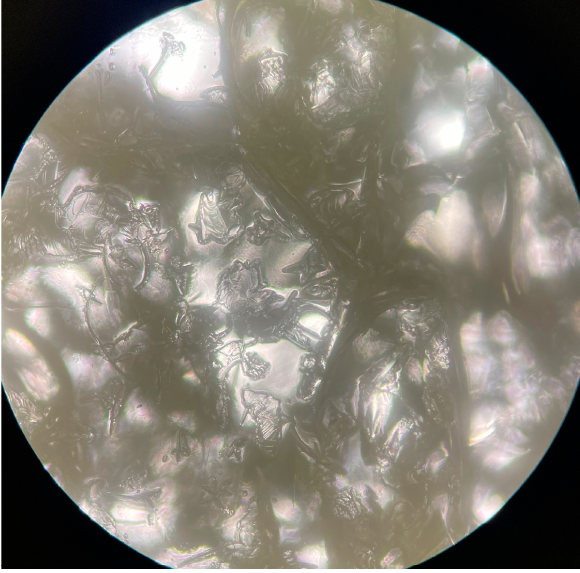
Figure 12. Microscopic view of dried FC34 disc after three cycles of pulsatile swelling (Olympus CX23, magni fi cation 40×).